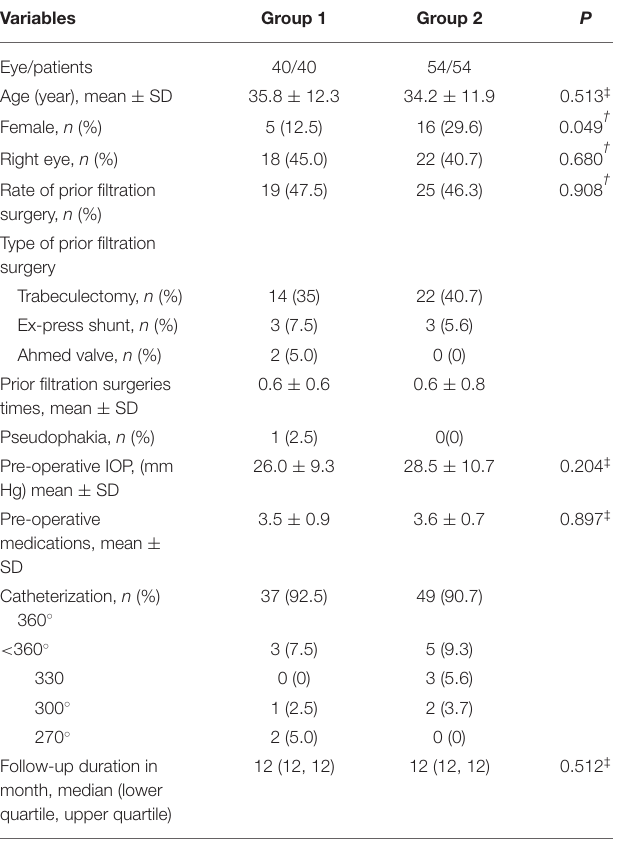
TABLE 1 | Demographics of study population with baseline